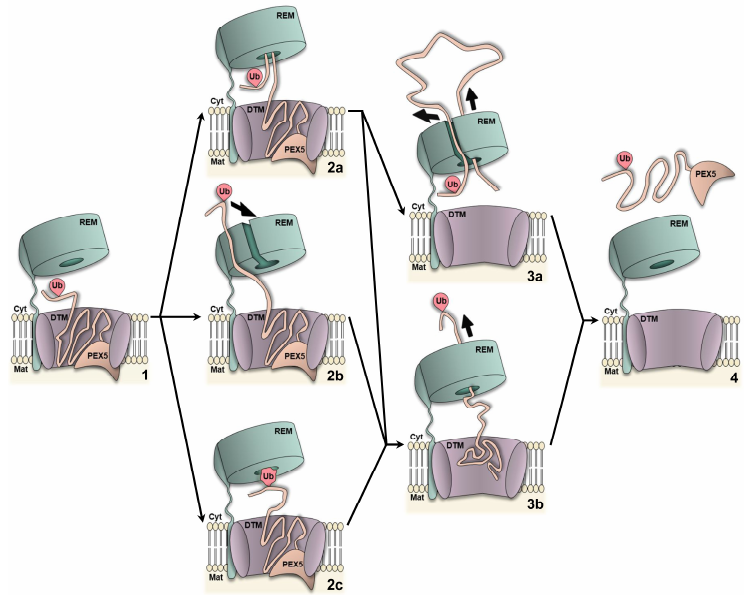
Figure 3 Figure 3. Possible mechanisms of PEX5 engagement and extraction by the REM.